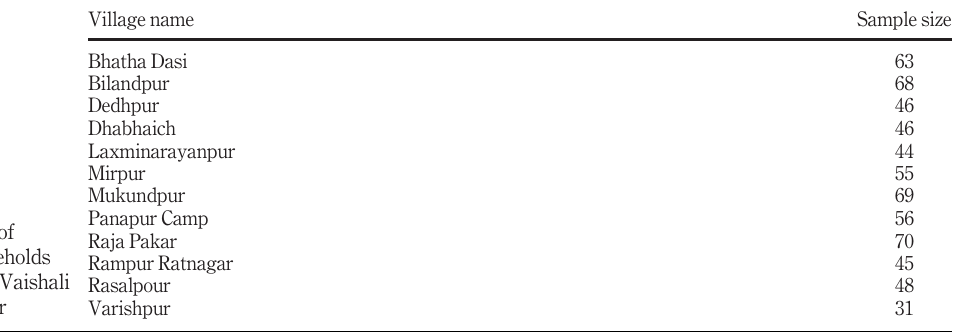
sample households by village in